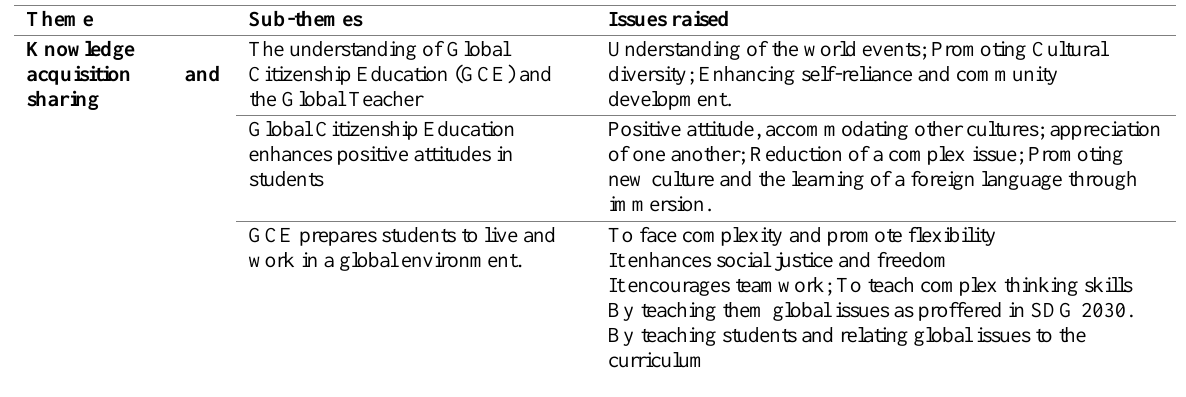
Table 5: Themes and sub-themes concerning the understanding of Global Citizenship Education (GCE) and the Global